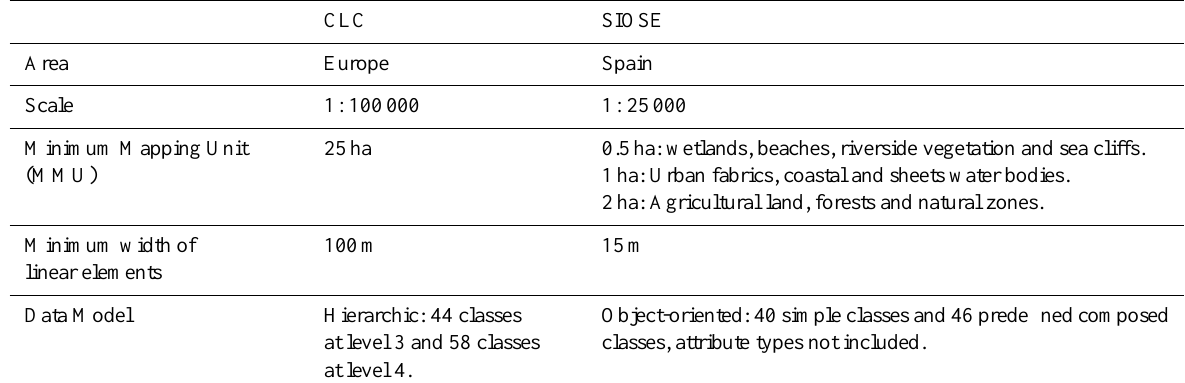
Table 1. Characteristics of the CLC and SIOSE models.